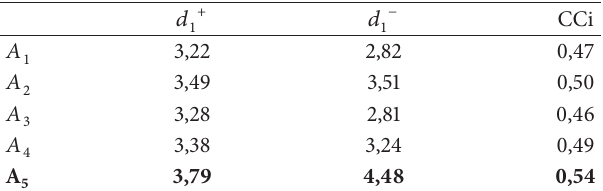
Table 17: Supplier selection